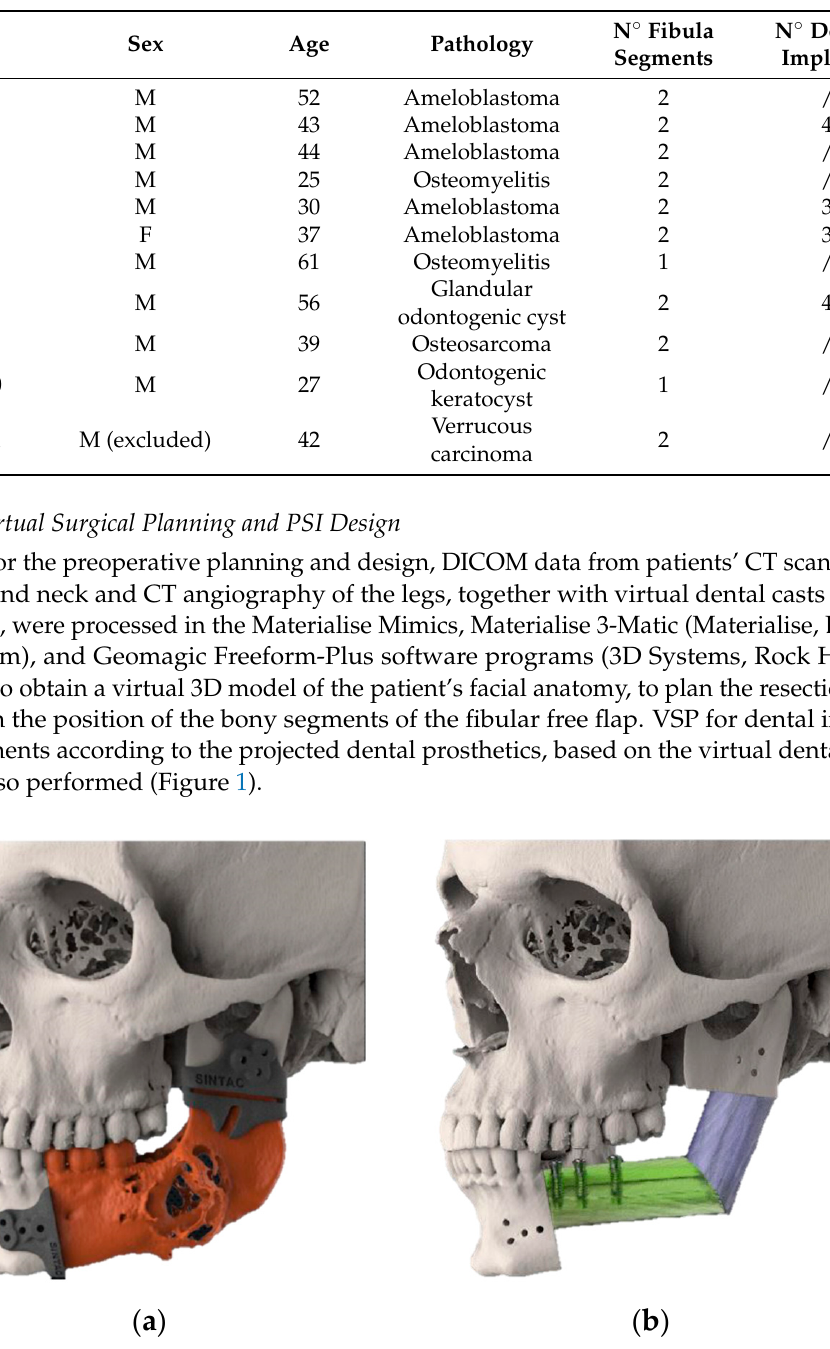
Table 1. The patient population.